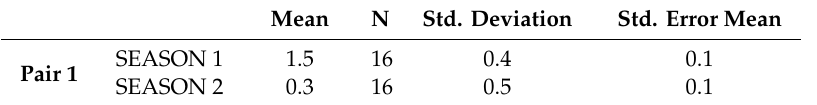
Table A3. Samples Statistics.